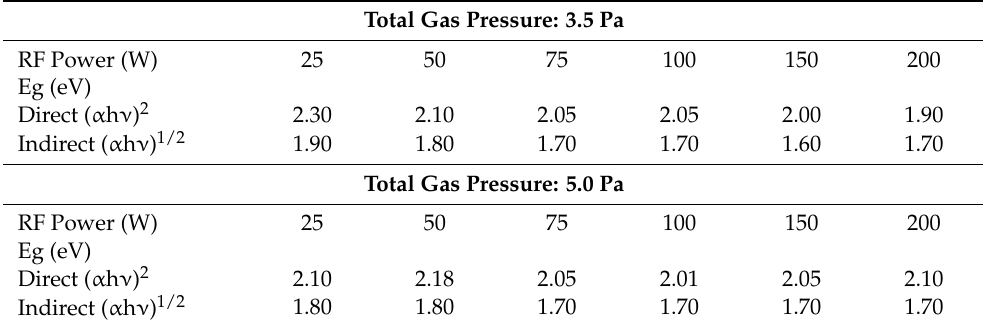
Table 6. Direct and indirect band gap energy values calculated for the Cu 3 N films fabricated on glass in a pure N 2 atmosphere at different RF powers.